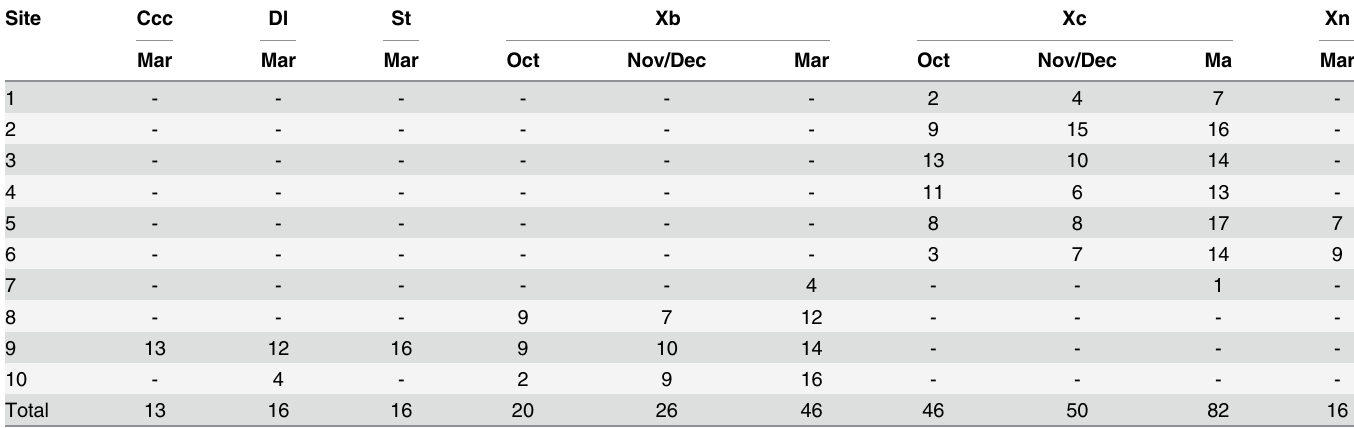
Table 1. Number of individual fleas analyzed from each flea species across three collection